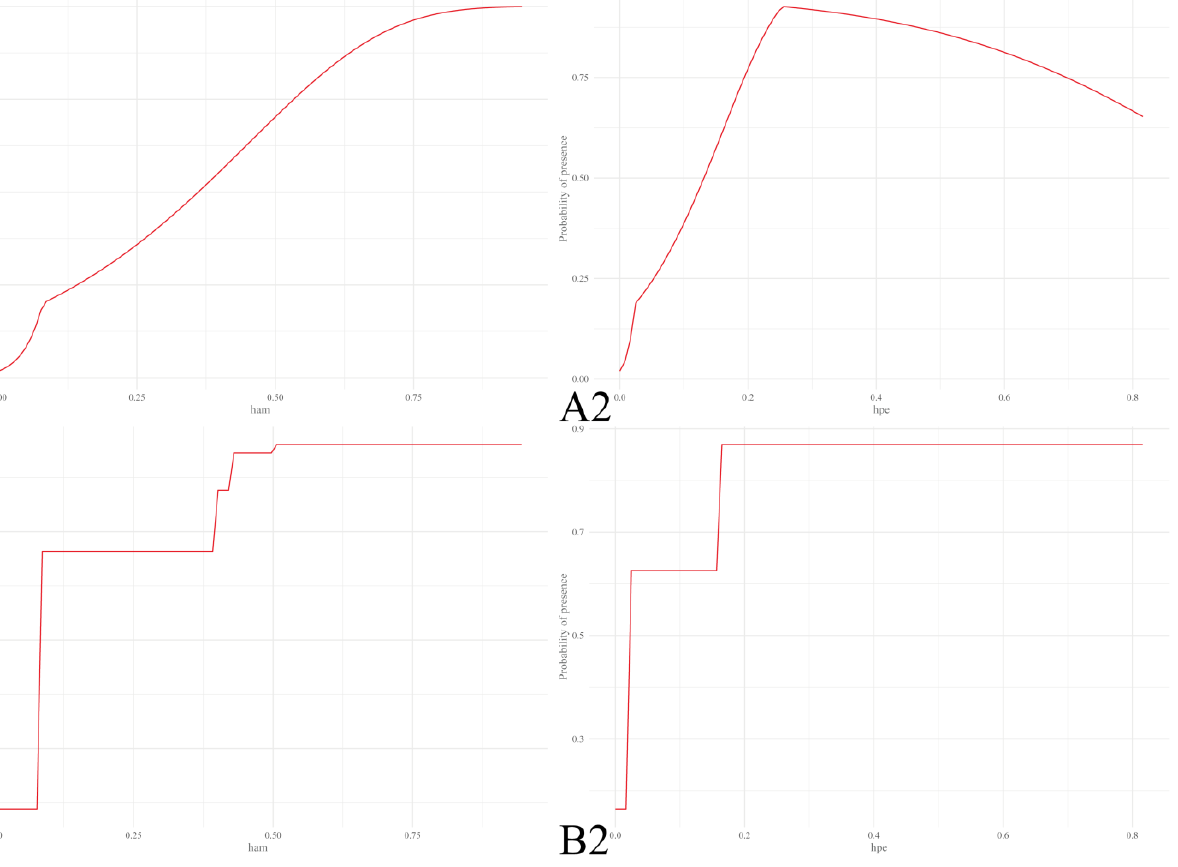
Figure 6. The response curves of hosts in two strategies (( A1 ): the response curve of Haloxylon. ammondendron (C. A. Mey.) Bunge in AH strategy; ( A2 ): the response curve of H. persicum Bunge ex Boiss in AH strategy; ( B1 ): the response curve of H. ammondendron in HO strategy; ( B2 ): the response curve of H. persicum in HO strategy). The AH/HO means the strategy of abiotic and host factors or host factors only.